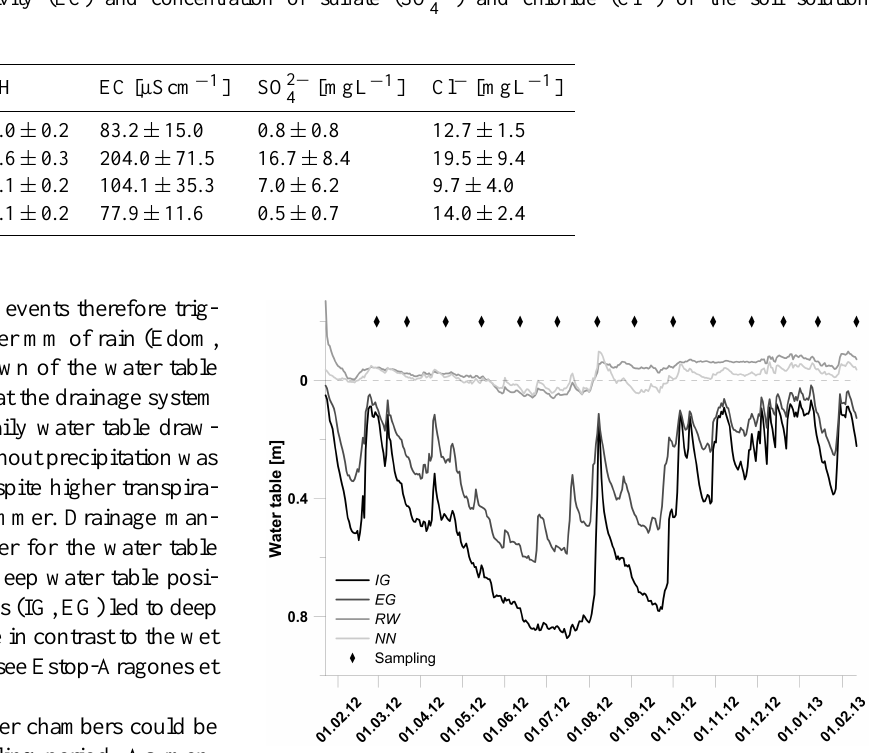
Fig. 3. Groundwater table dynamics at the study sites during the complete sampling period (February 2012–February 2013). The dashed line represents the soil